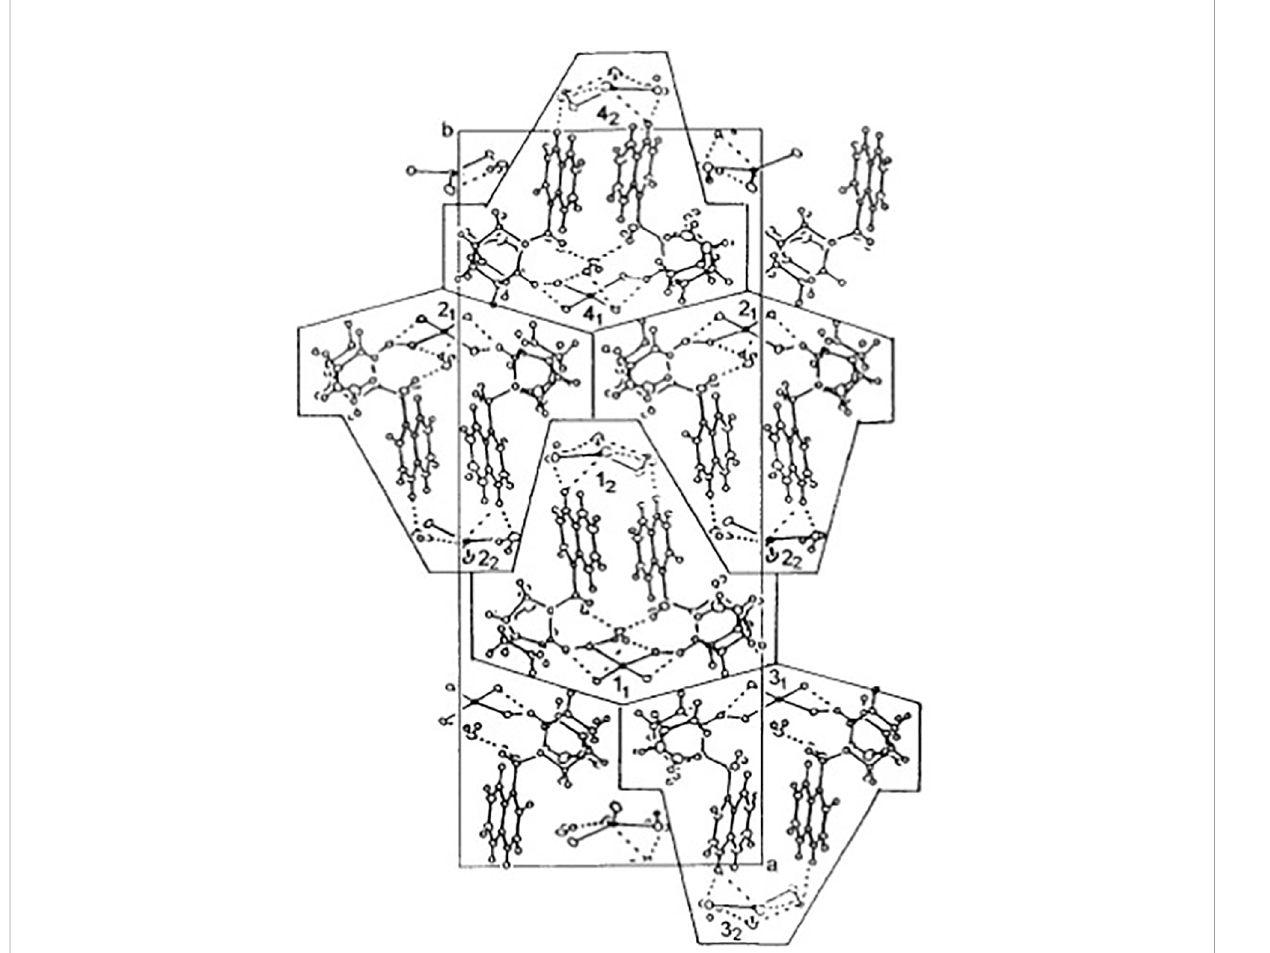
FIGURE 1 Chemical structures of CuCl 4 -tetrahedra in Bis[Cinchoninium Tetrachlorocuprate(II)]trihydrate (CinCu). Projection of the unit cell along the c- axis at 100 K. The cages contain single molecules [(cinH 2 ) 2+ (CuCl 4 ) 2- ] 2 ·3H 2 O marked as 1-4 with two geometrically inequivalent (CuCl 4 ) 2- anions marked by subscripts 1 and 2. The cages 1-2 and 3-4 form two-dimensional planes parallel to the ac-plane coupled by dispersive forces only. Nitrogens assigned numbers are 1 and 13; oxygen, number 12; carbons, the other numbers smaller than 23; and hydrogen, 23 – 44 Adapted with permission from {Inorg. Chem. 2001, 40, 18, 4526 – 4533 Publication Date:July 28, 2001 https://doi.org/10.1021/ic001402a}. Copyright {2001} American Chemical